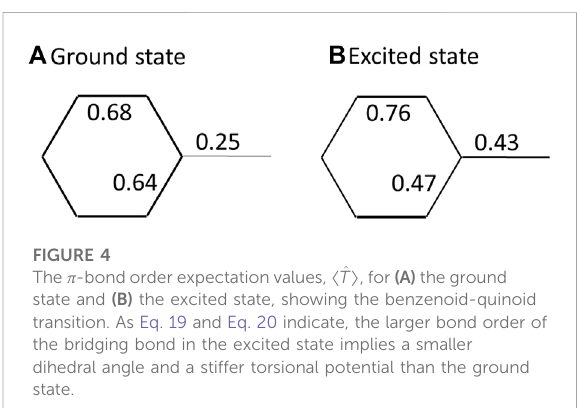
FIGURE 4 The π -bond order expectation values, 〈 ^ T 〉 , for (A) the ground state and (B) the excited state, showing the benzenoid-quinoid transition. As Eq. 19 and Eq. 20 indicate, the larger bond order of the bridging bond in the excited state implies a smaller dihedral angle and a stiffer torsional potential than the ground